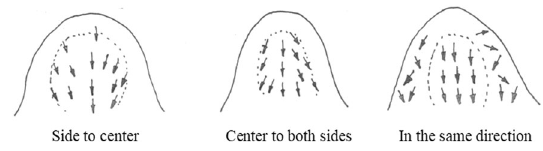
Fig. 6 Features of plane displacement vector of the observation points